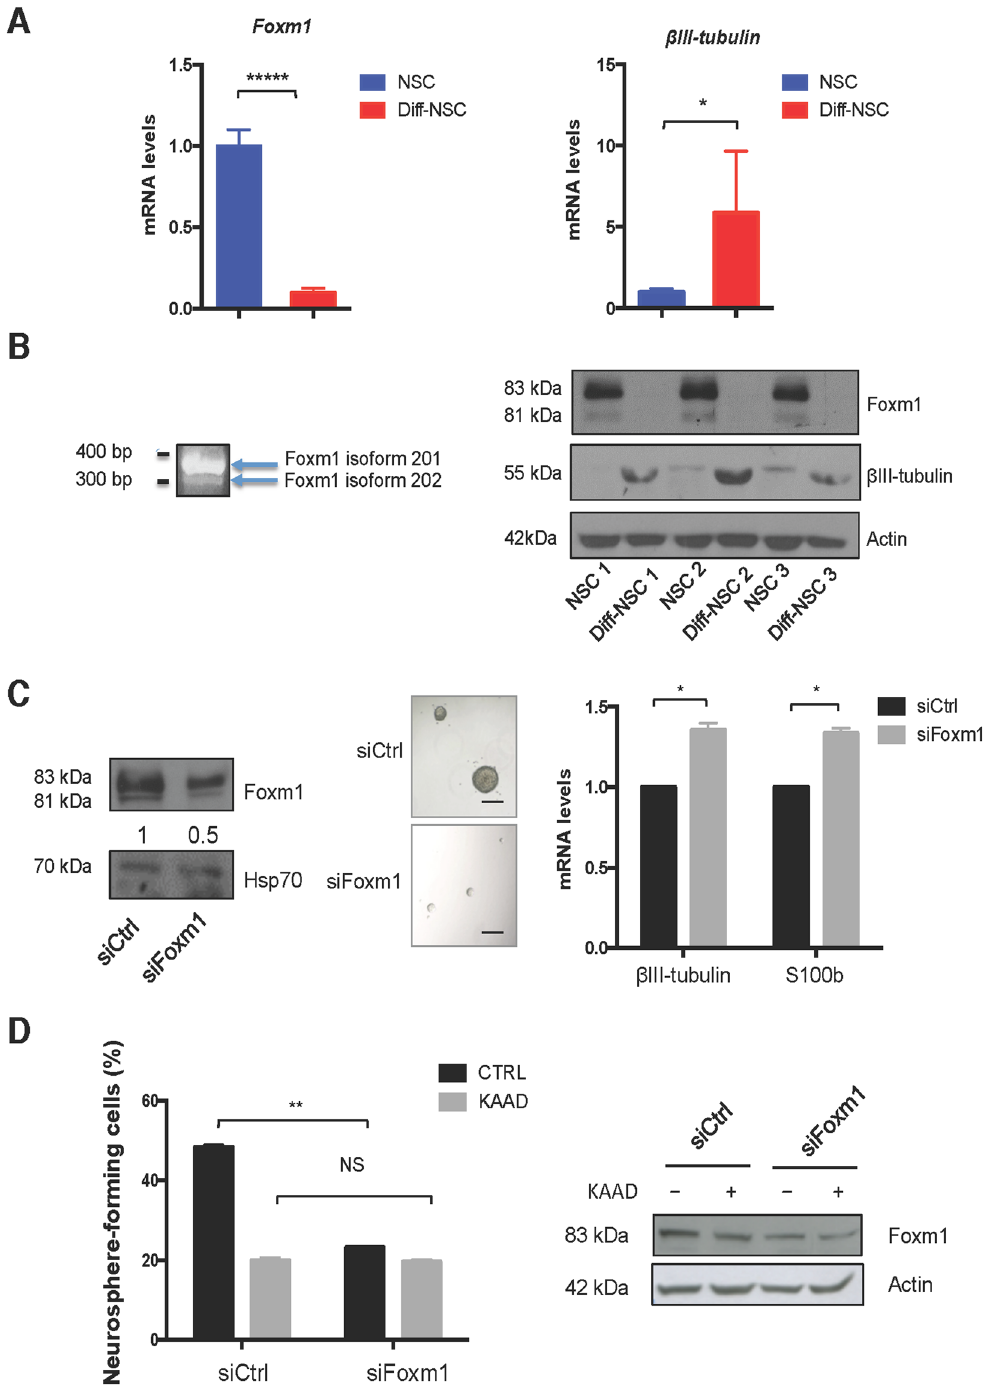
Figure 2. Upregulated expression of Foxm1 in P4 cerebellar NSCs and its effect on self-renewal. ( A ) RT- qPCR data showing differential expression in pre- and post-differentiation NSCs of mRNA for Foxm 1 ( ***** P < 0.0001: 0.0000089) and the neuronal differentiation gene β III-tubulin ( * P < 0.05: 0.029) (Mann– Whitney U test). ( B ) Left : PCR assay of Foxm1 expression using isoform-specific primers. Agarose (2%) gel separation of the amplified product yielded two bands corresponding to Foxm1 isoforms 201 (400 bp) and 202 (300 bp). Full-length gel is presented in Supplementary Figure 8A. Right : Immunoblots showing endogenous levels of Foxm1, β III-tubulin, and Actin (loading control) in three NSC cultures before and after differentiation. Full-length immunoblots are presented in Supplementary Figure 8B. ( C ) Left: Immunoblots showing endogenous levels of Foxm1 and Hsp70 (loading control) in NSCs transfected with siRNA against Foxm1 or non-targeting siRNA controls (siCtrl). Densitometric values appear below blots. Full-length immunoblots are presented in Supplementary Figure 8C. Middle: Representative bright-field images of neurospheres formed by NSCs transfected with siCtrl and siFoxm1. Scale bar: 100 μ m. Right: RT-qPCR data showing mRNA